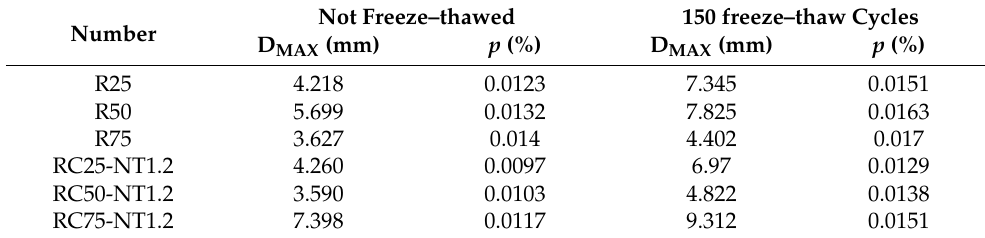
Figure 9. Macroscopic pore diagram of recycled aggregate concrete at 150 freeze – thaw cycles. Table 8. Macroscopic porosity (%) and maximum pore diameter